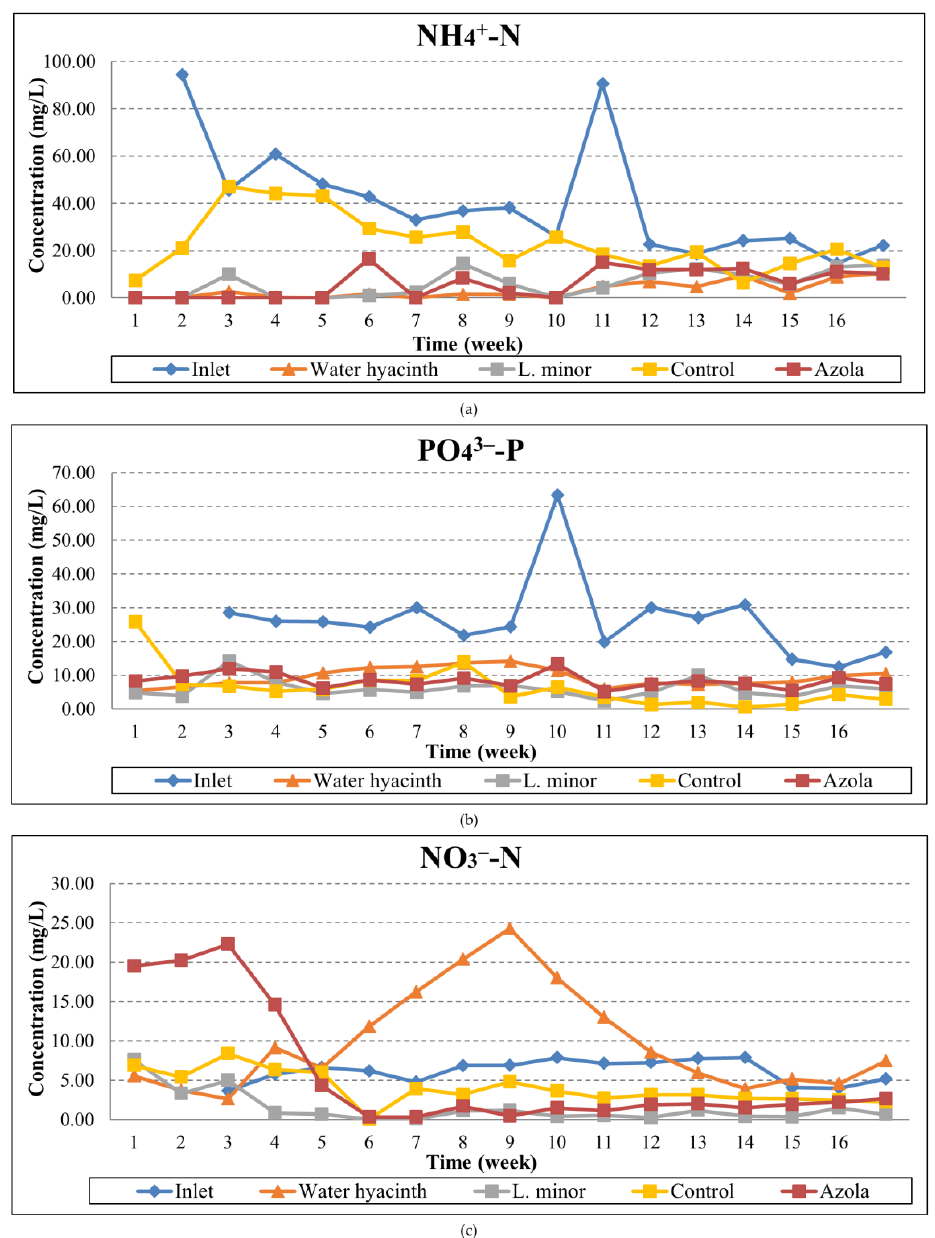
Figure 5. Temporal variation of: ( a ) NH 4+ -N, ( b ) PO 43 − -P, ( c ) NO 3 − -N concentrations at the inlet and the outlet of the three tanks throughout the operation period.